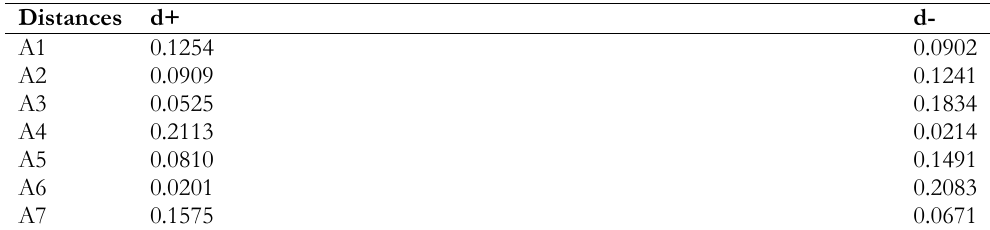
Table 26. The distance between positive and negative ideas.